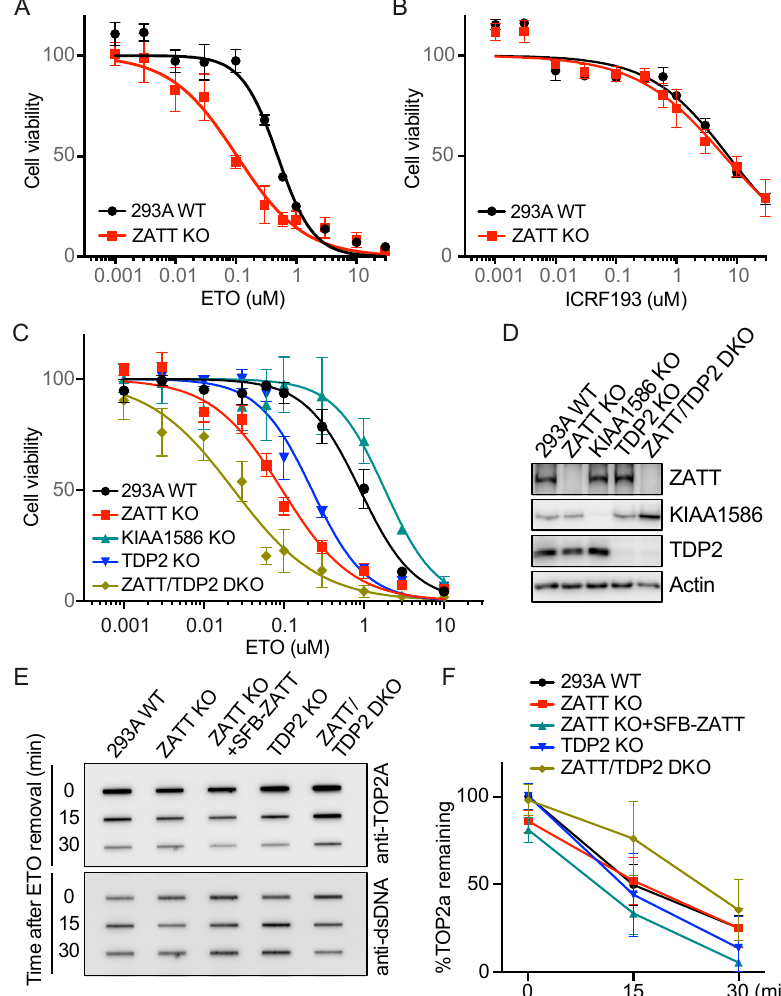
Figure 1. ZATT KO cells showed higher ETO sensitivity than TDP2 KO cells. ( A , B ) Cell survival was measured using a CellTiter-Glo assay in HEK293A WT and ZATT KO cells treated with indicated drugs for 3 days. Each experiment was repeated three independent times done in triplicate each time. Data were represented as mean ± SD. ( C ) Cell survival was measured by a CellTiter-Glo assay after 3 days in the presence of the indicated concentrations of ETO. Each experiment was repeated three independent times done in triplicate each time. Data were represented as mean ± SD. ( D ) HEK293A were infected with pLenti ‐ V2 ‐ sgRNAs that target ZATT, KIAA1586, or TDP2 to gen ‐ erate KO cells. Whole ‐ cell extracts were prepared and subjected to western blotting with the indi ‐ cated antibodies. ( E ) Cells were pretreated with 20 uM MG132 for 1.5 h and then incubated with 100 μ M ETO for 1 h. Cells were incubated with fresh medium containing MG132 for indicated recovery times and subjected to RADAR assay. The removal rate of TOP2cc was analyzed using immune ‐ slot blotting with TOP2 antibody. dsDNA antibody was used to monitor the amount of DNA loaded in each sample. ( F ) Quantitation of TOP2cc from three independent experiments as shown in ( E ). TOP2cc were measured by densitometric analyses of slot blot signals and plotted as averages and standard deviations.